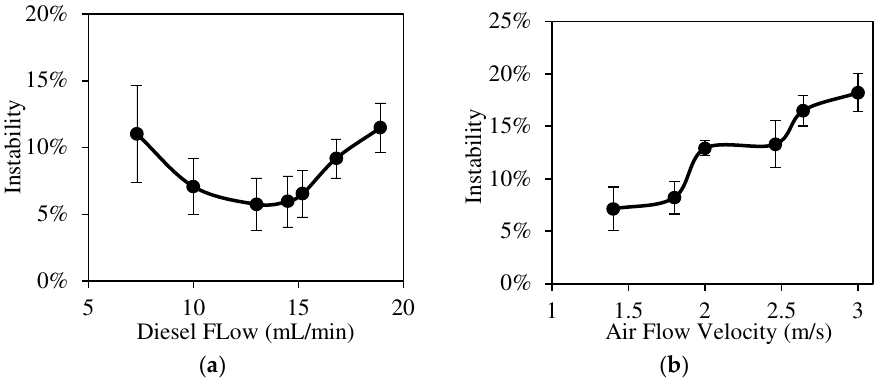
Figure 10. The instability of combustion under ( a ) different diesel flow rates and ( b ) air flow velocities.